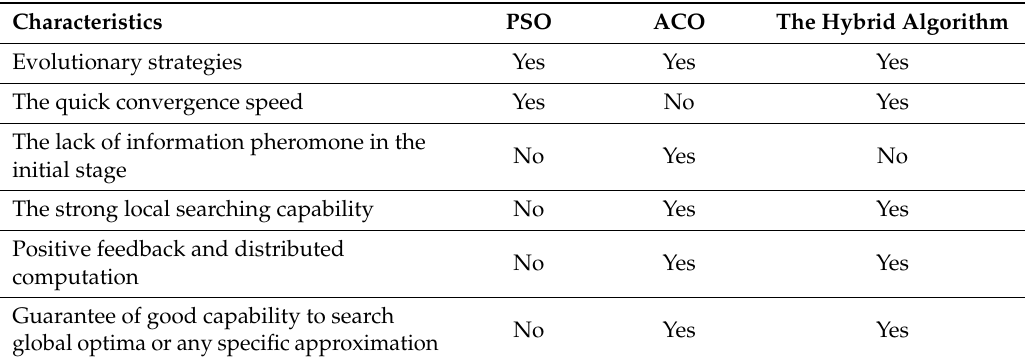
Table 1. Advantages and disadvantages of particle swarm optimization (PSO), ant colony optimization (ACO), and the proposed hybrid